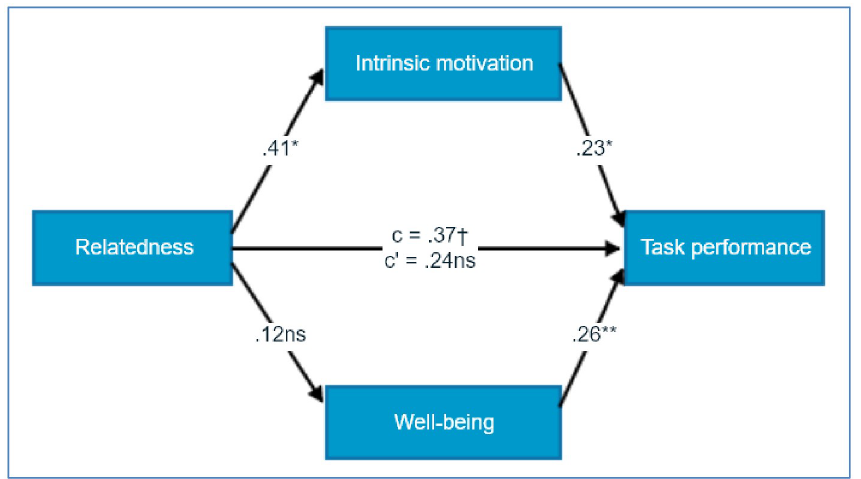
Fig 2. Standardised regression coefficients for the mediational effects of intrinsic motivation and well-being in the relationship of competence and task performance level in Study 1.